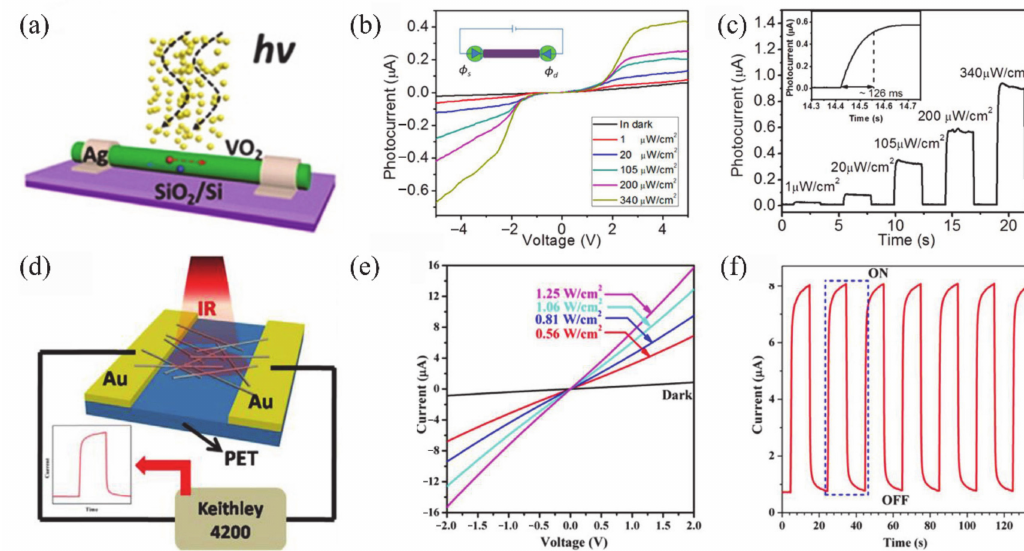
Figure 23. ( a ) Schematic diagram of a UV light photodetector based on a single VO 2 microwire. ( b ) The I–V characteristic curves of VO 2 photodetector under illumination of the different UV intensities. ( c ) Photocurrent measured under different UV intensities at a bias voltage of 4 V, and inset is the response time. Reproduced from [163], with permission from American Chemical Society, 2014. ( d ) Schematic diagram of IR light photodetector based on VO 2 NWs. ( e ) I–V characteristics of the device at different IR radiation intensities. ( f ) Photocurrent response of the VO 2 device under a periodic light illumination at a bias voltage of 1.5 V. Reproduced from [164], with permission from Elsevier,